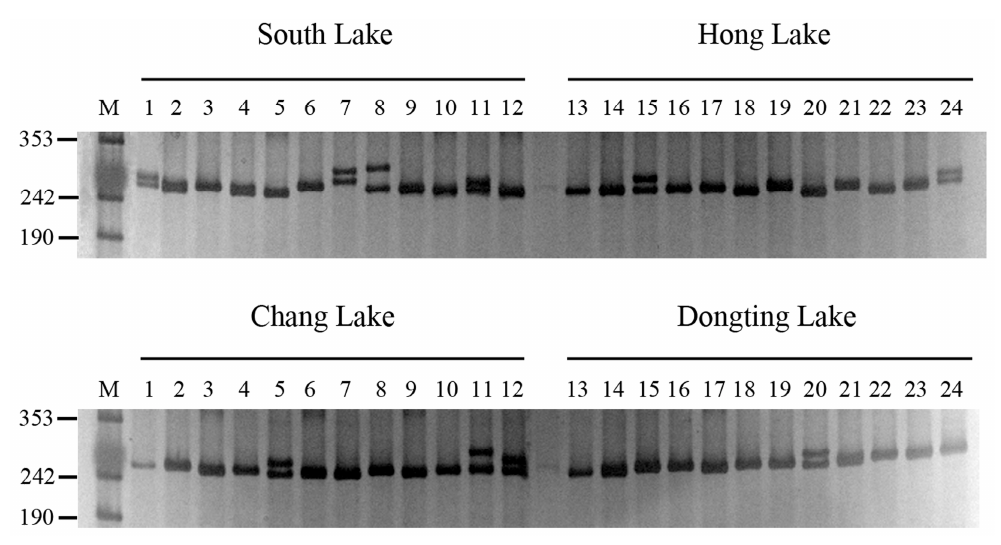
Figure 3. PCR amplification profiles of 48 yellow catfish accessions using primer pair H86. The PCR amplified products were separated on 7% polyacrylamide gel. M indicated the molecular